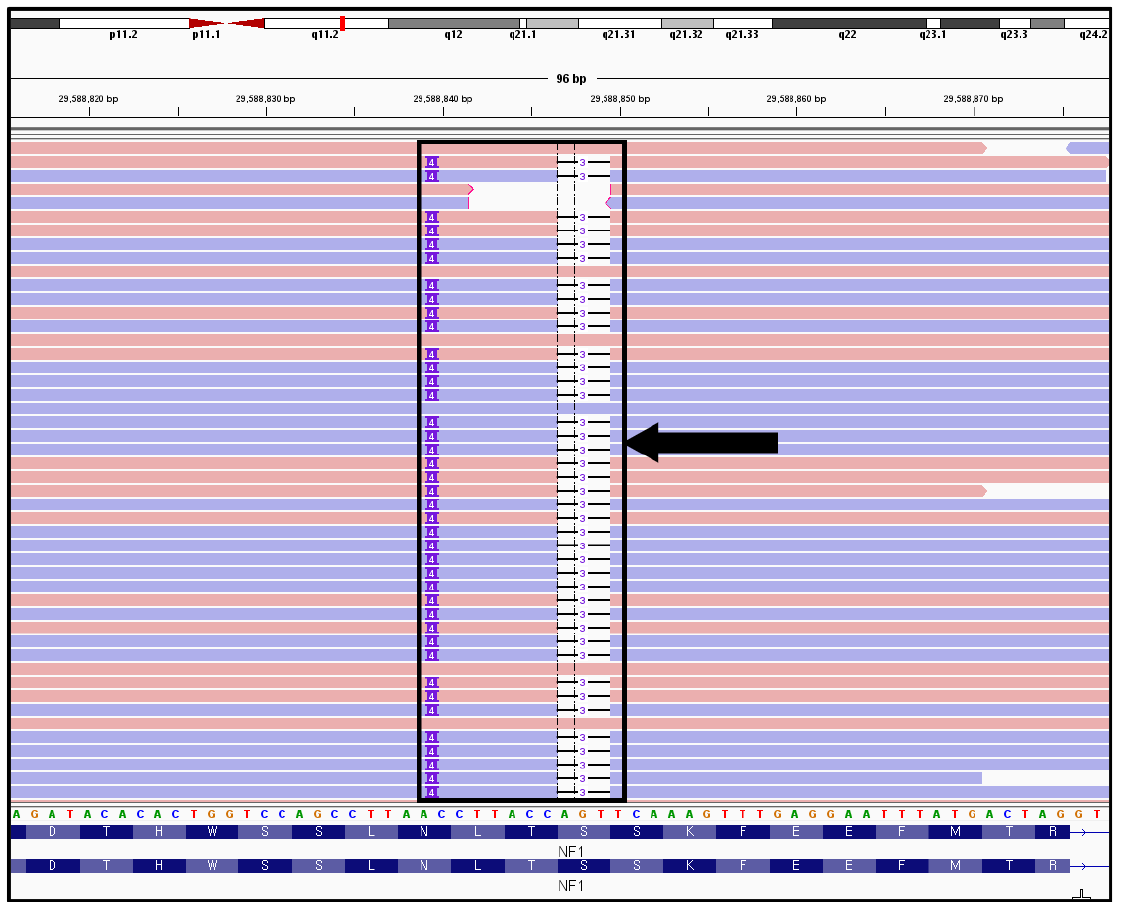
Figure 2. Screen capture of the Integrative Genomic Viewer tool. It shows the content of the Binary Alignment Map (BAM) file, obtained from NGS study, from the position 29,588,800 to 29,588,895 (hg19 version reference genome) of chromosome 17. The block arrow and box indicates the indel variant NM_001042492.2(NF1):c.4691_4698delinsGGCCCTCCC. The BAM file was generated by Illumina MiSeq Dx system, which uses hybridization with oligonucleotide probes for target enrich- ment.